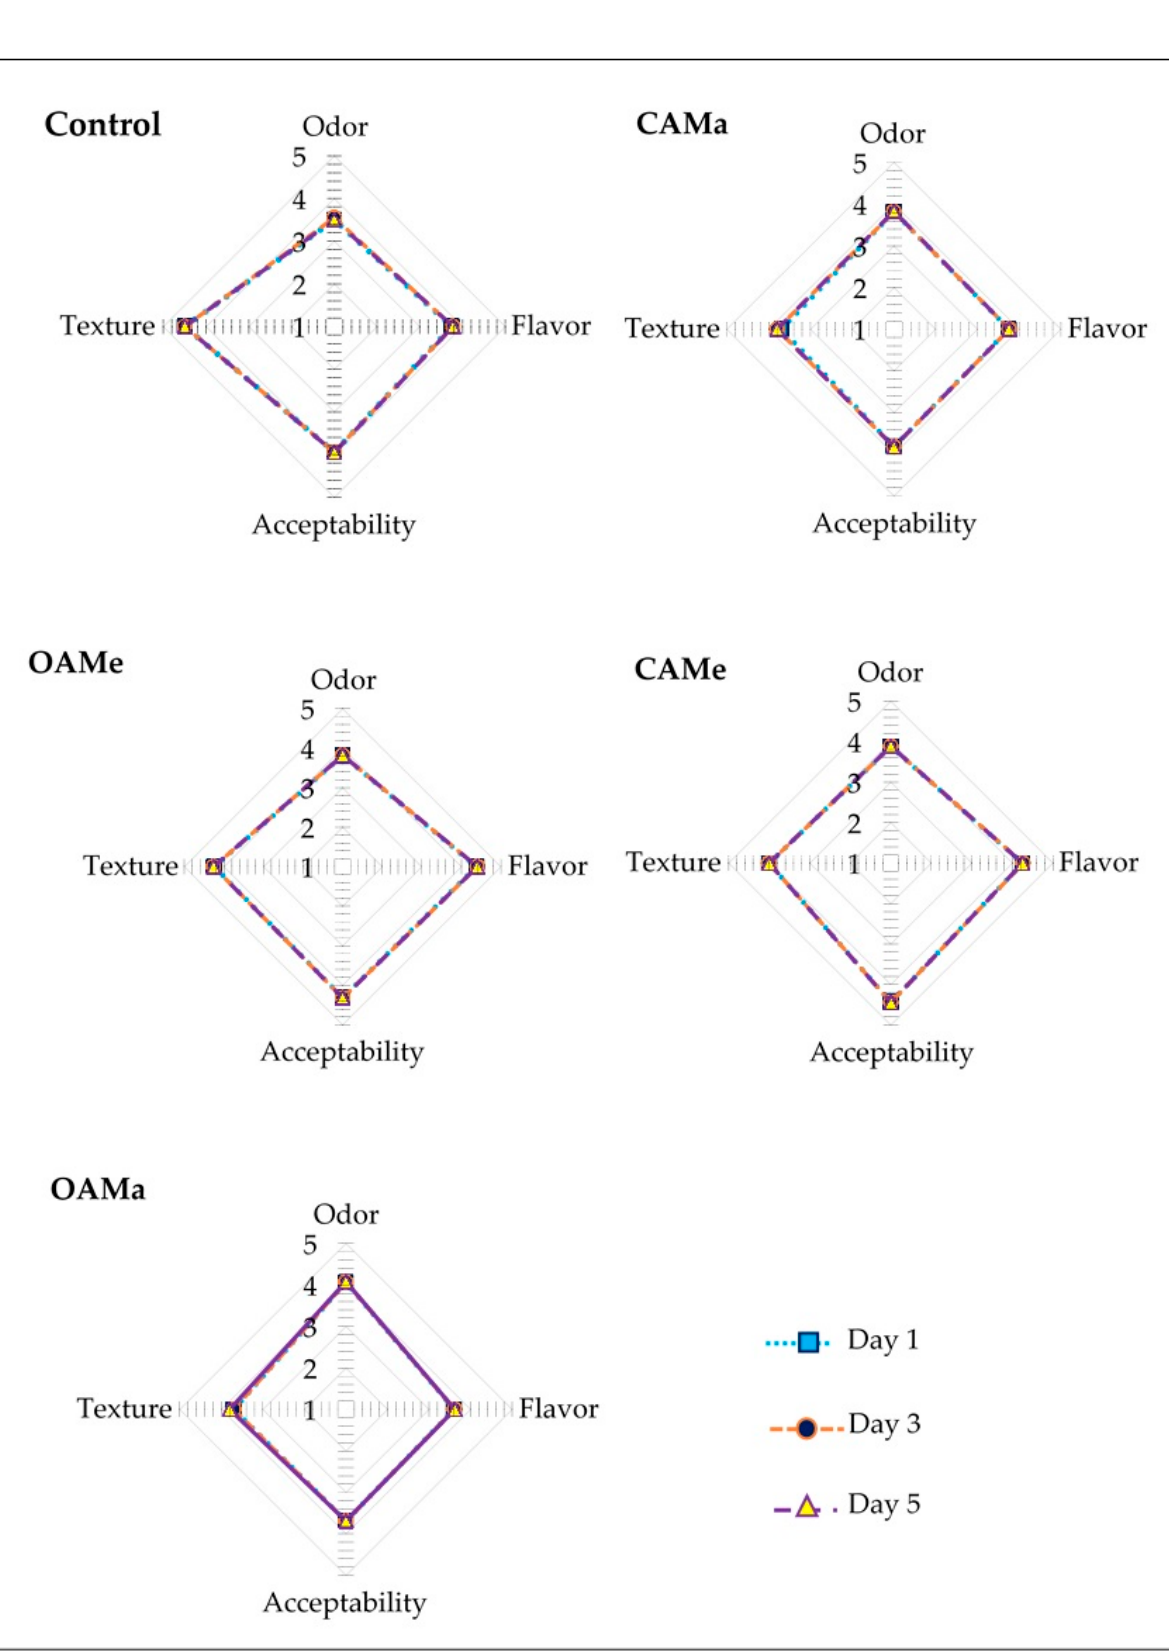
Figure 7. Sensorial evaluation of gluten-free muffins produced with ACF.